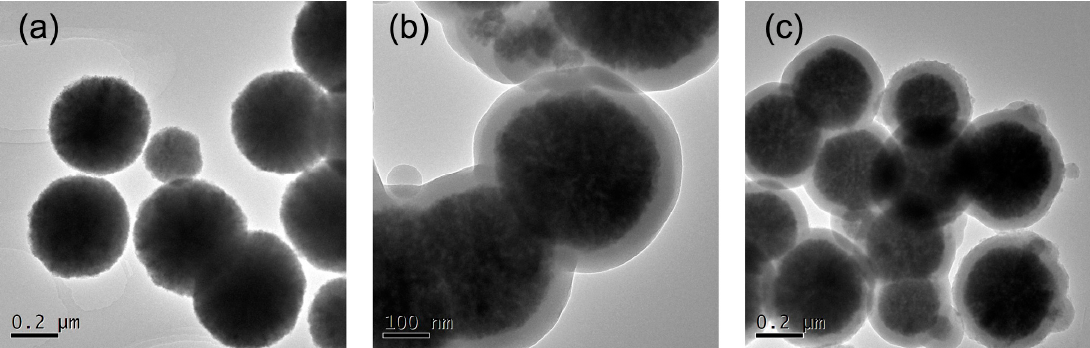
Figure 1. Transmission electron microscope (TEM) images of ( a ) Fe 3 O 4 nanoparticles; ( b ) silica coated Fe 3 O 4 nanoparticles (Fe 3 O 4 @SiO 2 ) nanoparticles and ( c ) xanthine oxidase immobilized silica coated Fe 3 O 4 nanoparticles (Fe 3 O 4 @SiO 2 -XO) nanoparticles.